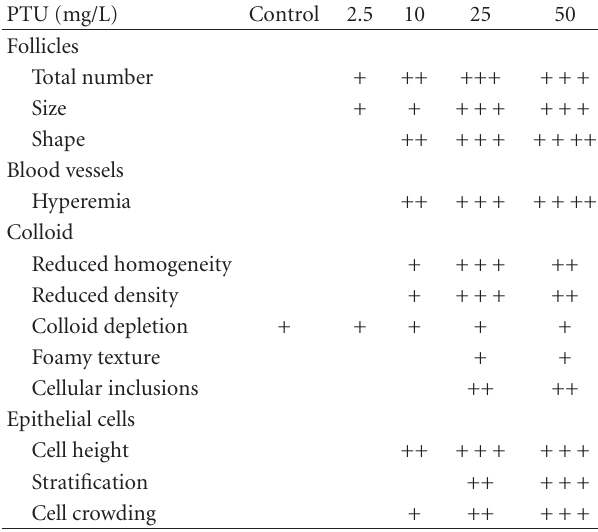
Table 2: Semiquantitative evaluation of alterations in the thyroid of zebrafish ( Danio rerio ) induced by